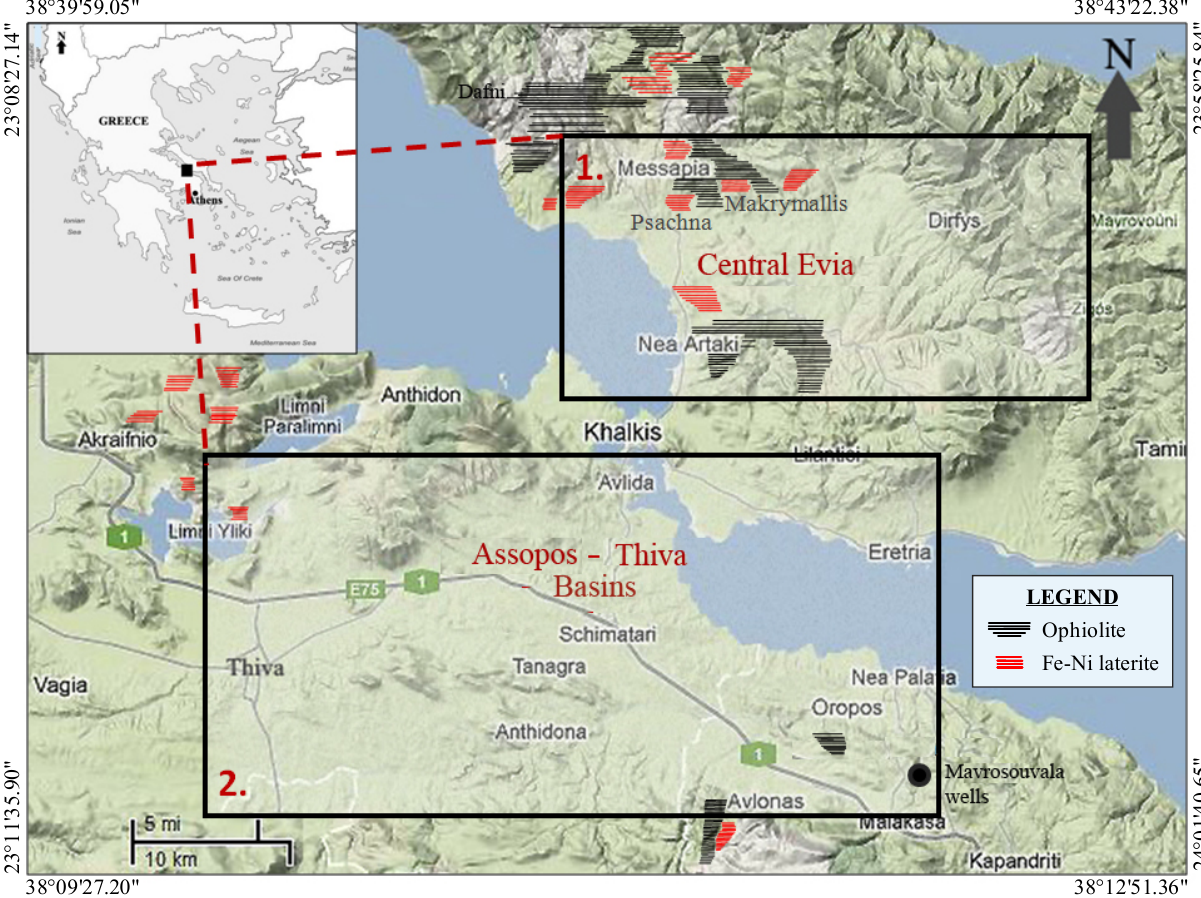
Figure 1. Location map showing the localities of